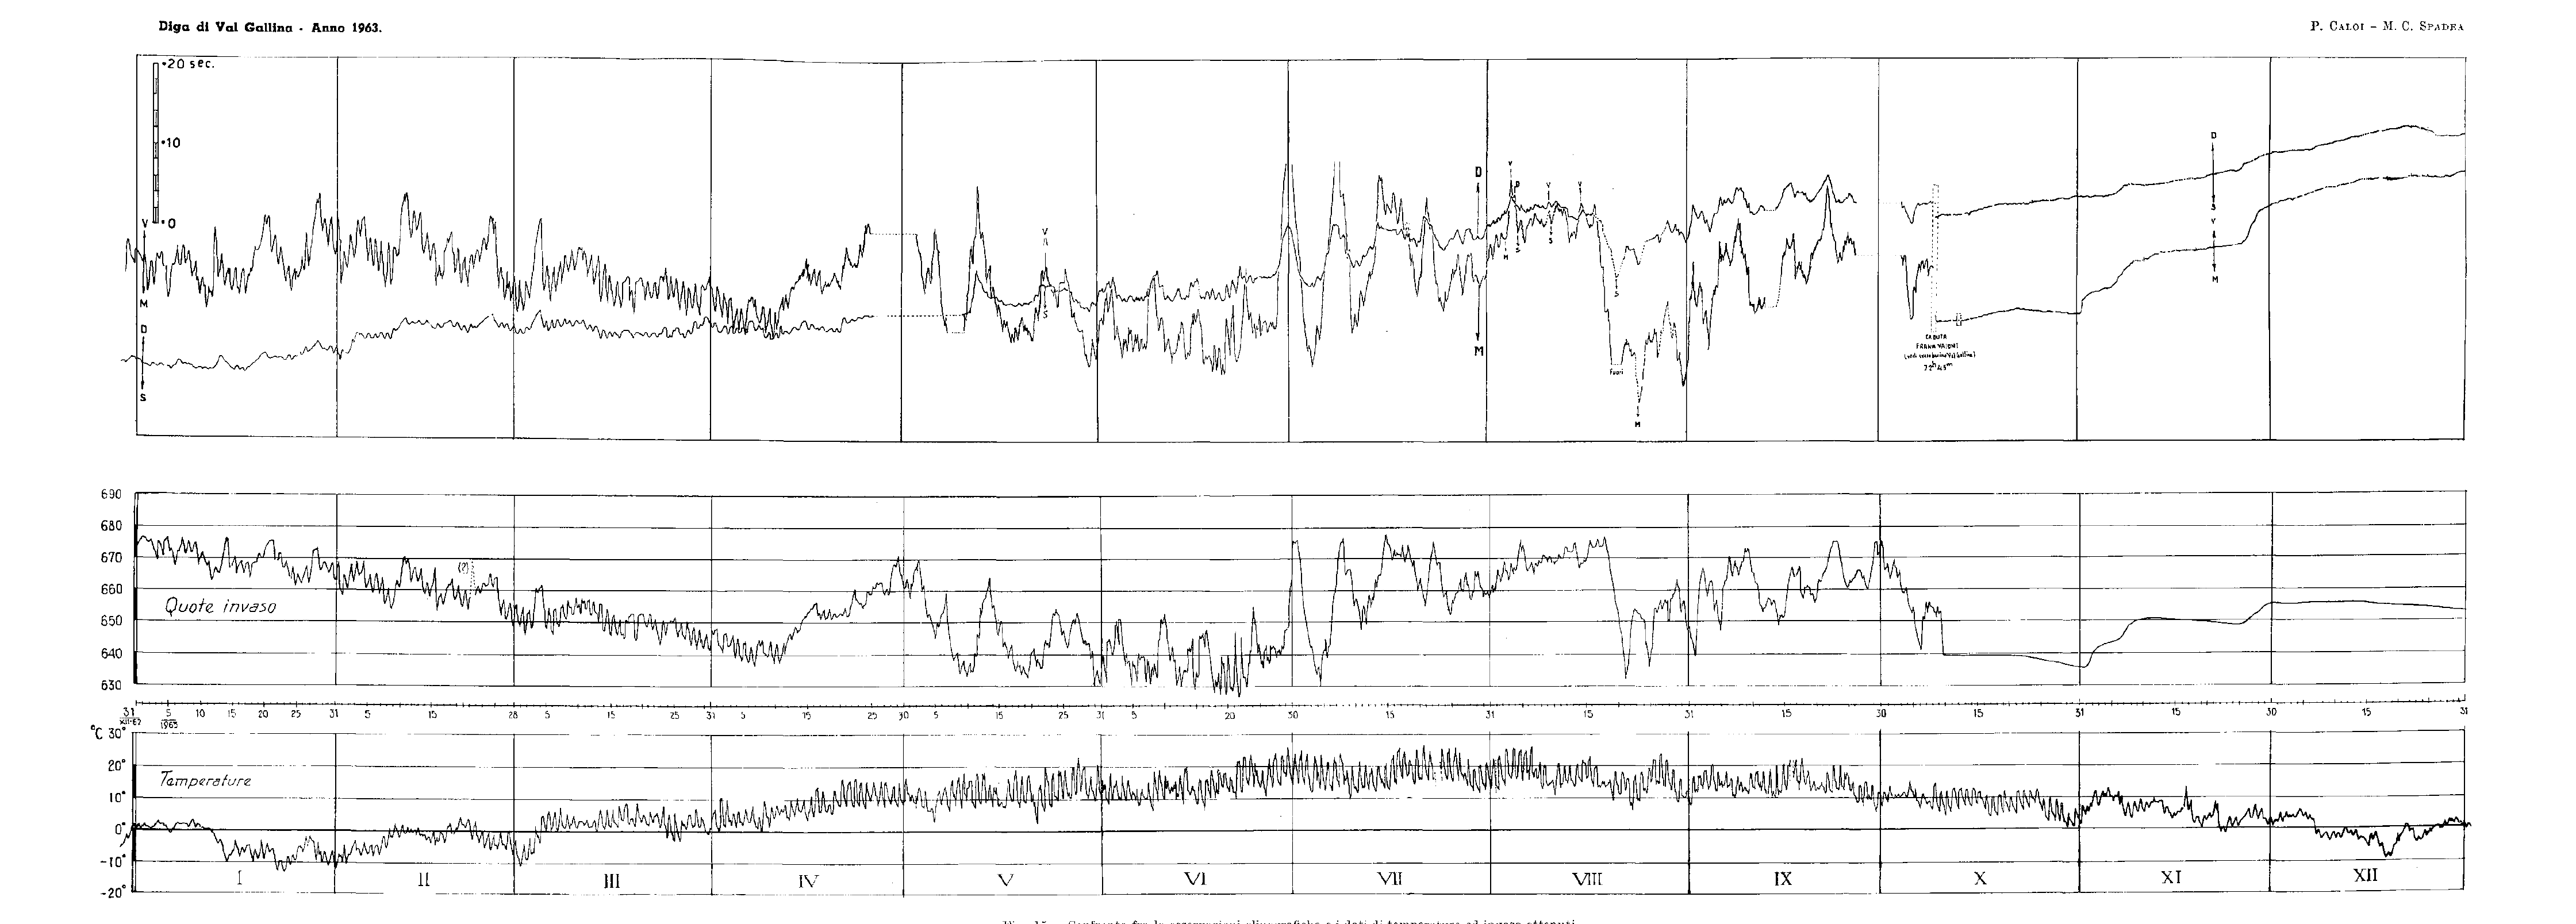
Fig. 15 - Confronto fra le osservazioni clinograflclie e i dati di temperatura ed invaso ottenuti presso la postazione elinograflca sita alla base della diga di Val Gallina nell'anno